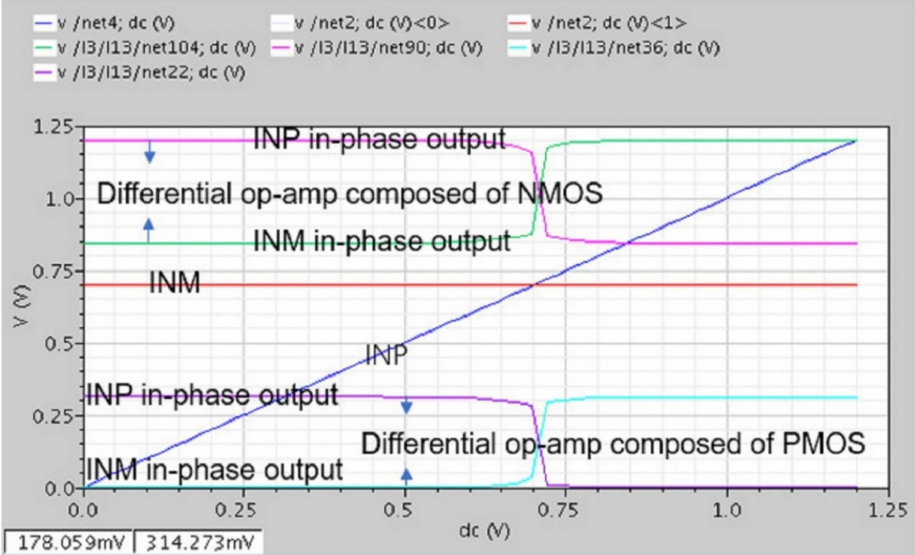
Figure 11. Differential amplifier